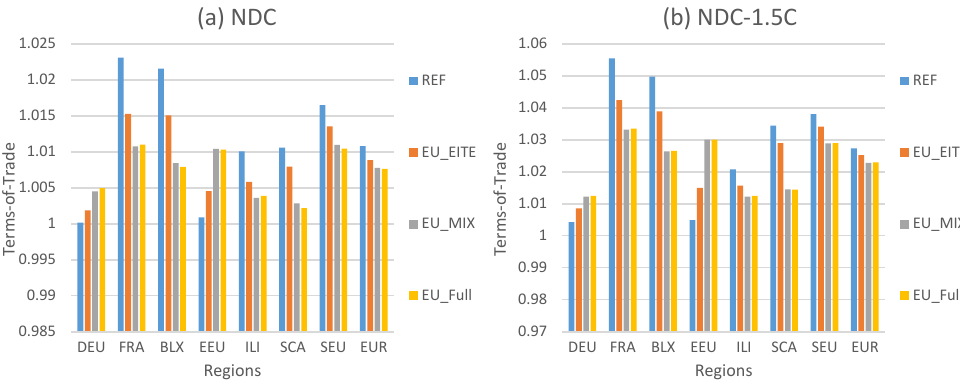
Figure 8. Terms-of-trade in the EU regions for different policy scenarios and NDCs using the IEO